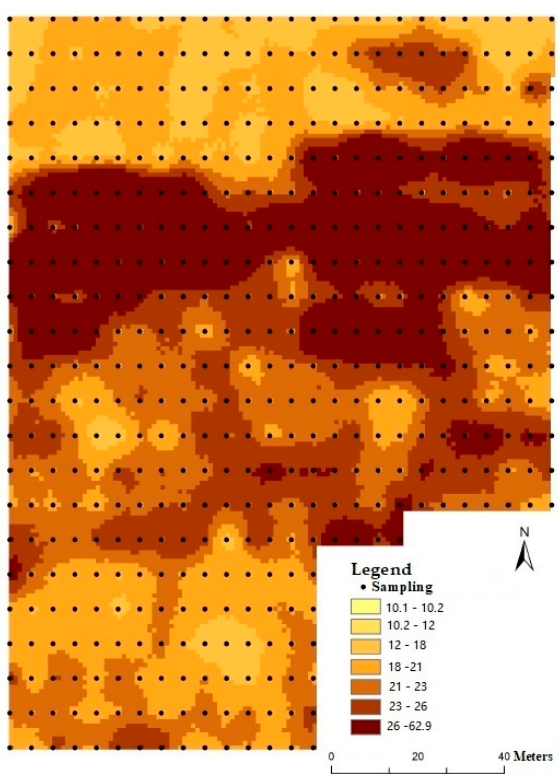
Figure 8. Grid map of VMC from 500 SGSs in the heading stage.